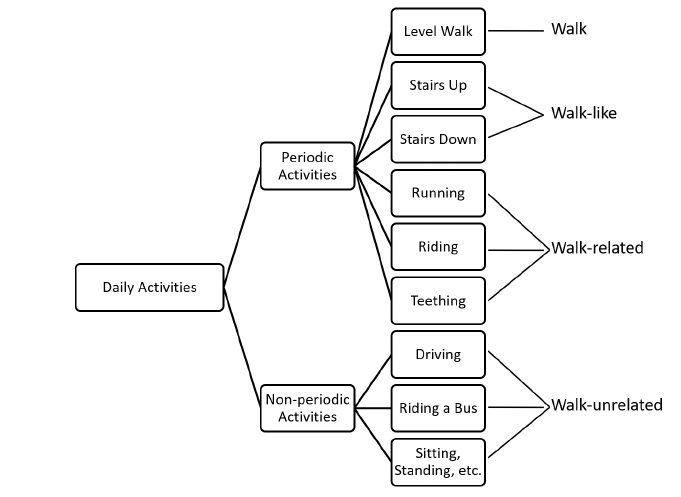
Figure 2. Hierarchical walk activity